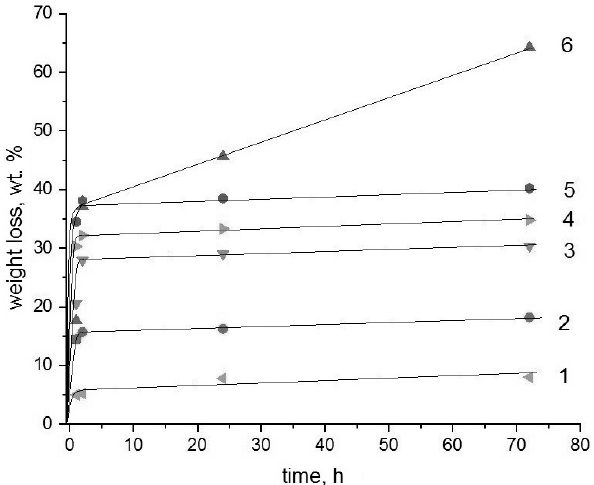
Figure 1. Weight loss kinetics for the binary composite films in the HCl solutions at 25 ° С . The numbers show: Solution concentrations are 0.005 (1), 0.1 (3), 0.2 (5) mol/L for a PHB-chitosan system and 0.005 (2), 0.1 (4), 0.2 (6) mol/L for a PLA-chitosan system.